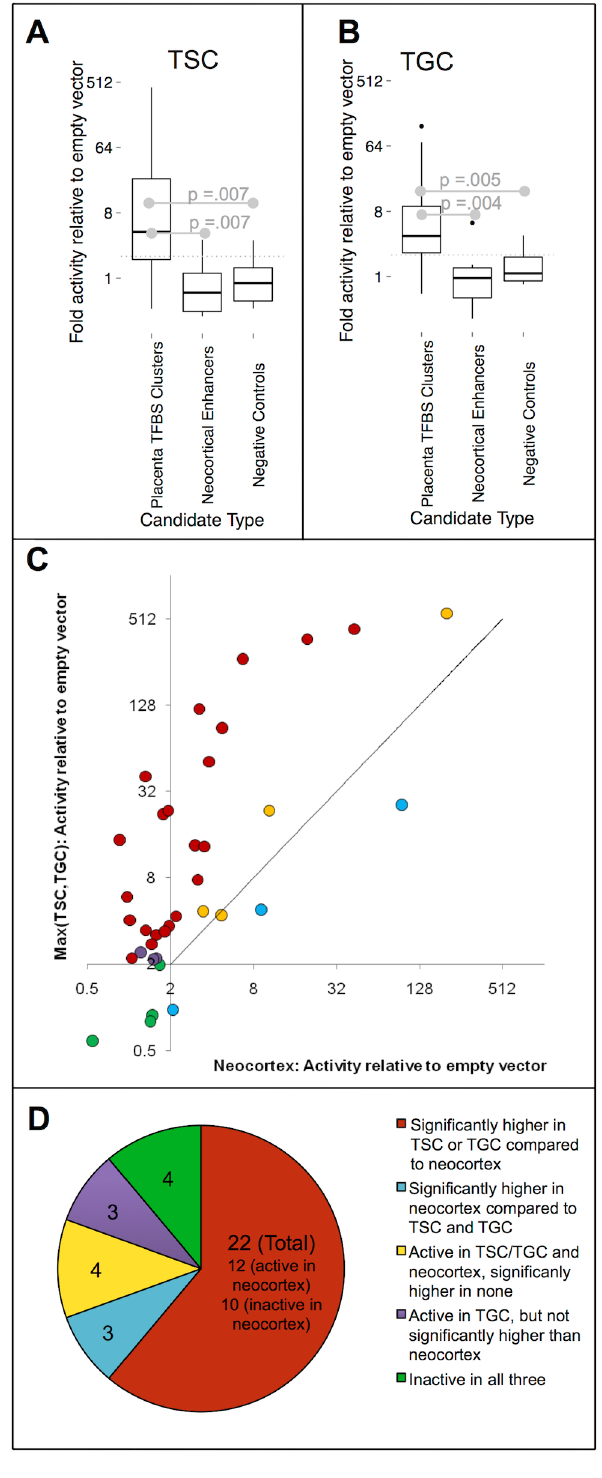
Figure 3. Luciferase activity of placenta TFBS cluster candi- dates. Box plots summarizing activity of placenta TFBS cluster candidates and negative controls in TSCs (A) and TGCs (B). Significance is calculated using the unpaired t -test. (C) Comparison of enhancer activity relative to empty vector for the higher value between TSCs and TGCs versus neocortical cells. In general, enhancers were much more active in at least one of TSCs and TGCs. Colors correspond to groups in (D). (D) Pie chart showing that the number of enhancers that